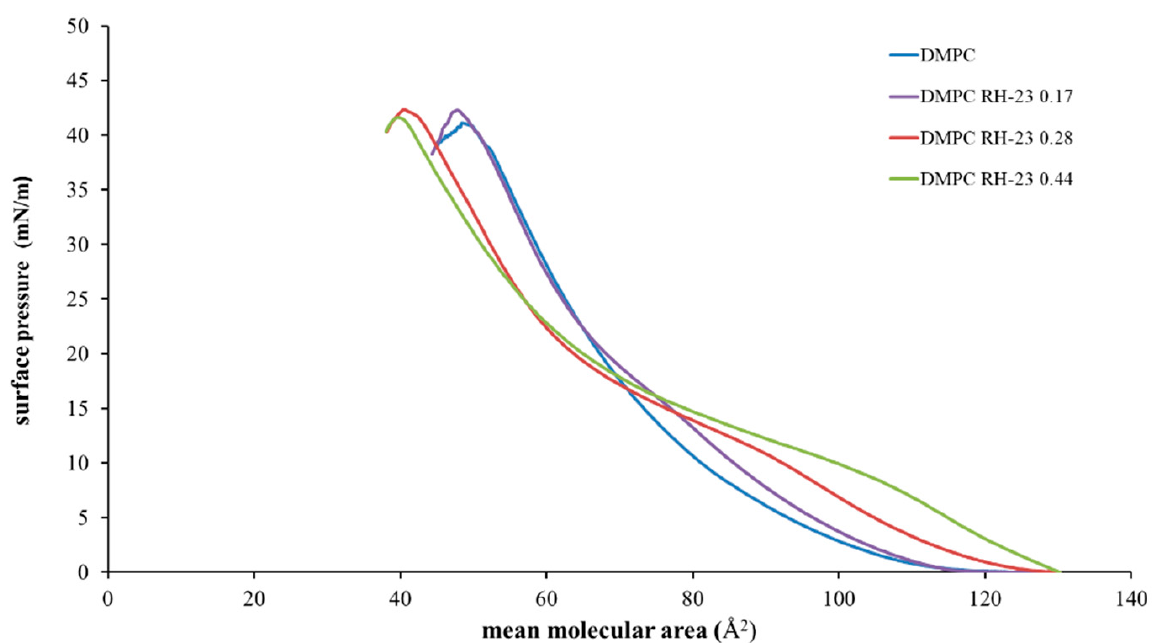
Figure 3. Surface pressure (mN/m)/mean area per molecule (Å 2 ) isotherms of DMPC monolayers in the presence of RH-23 at different molar fractions in the subphase, at a temperature of 37 °C and pH 7.4.